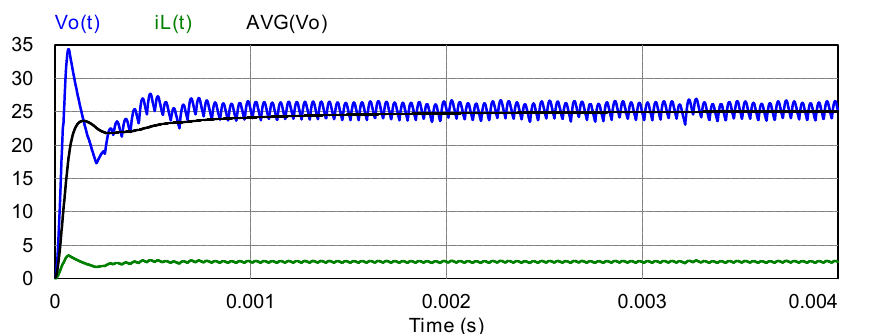
Figure 7. Output voltage v o ( t ) , its average value, and the inductor current i L ( t ) for reference signal v r = 25 V.